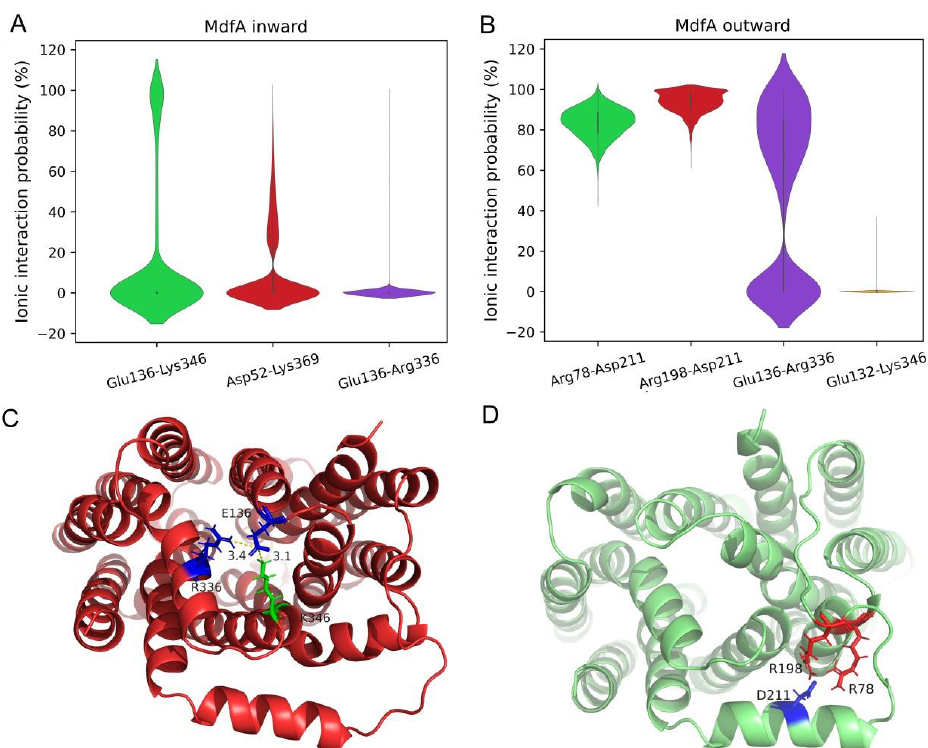
Figure 6. Salt bridges were altered between MdfA inward and MdfA outward . ( A , B ): Violin plot of possi- bilities of salt bridges between N- and C-repeats. ( C , D ): Visualization of salt bridges of MdfA inward1325 and MdfA outward74 at the cytoplasmic side.